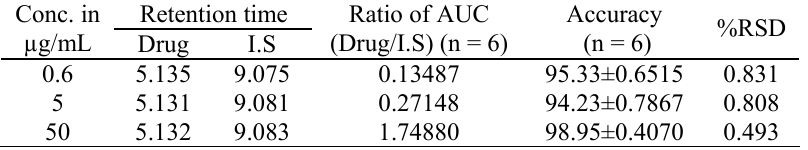
Table 5. Inter-day precision and accuracy of